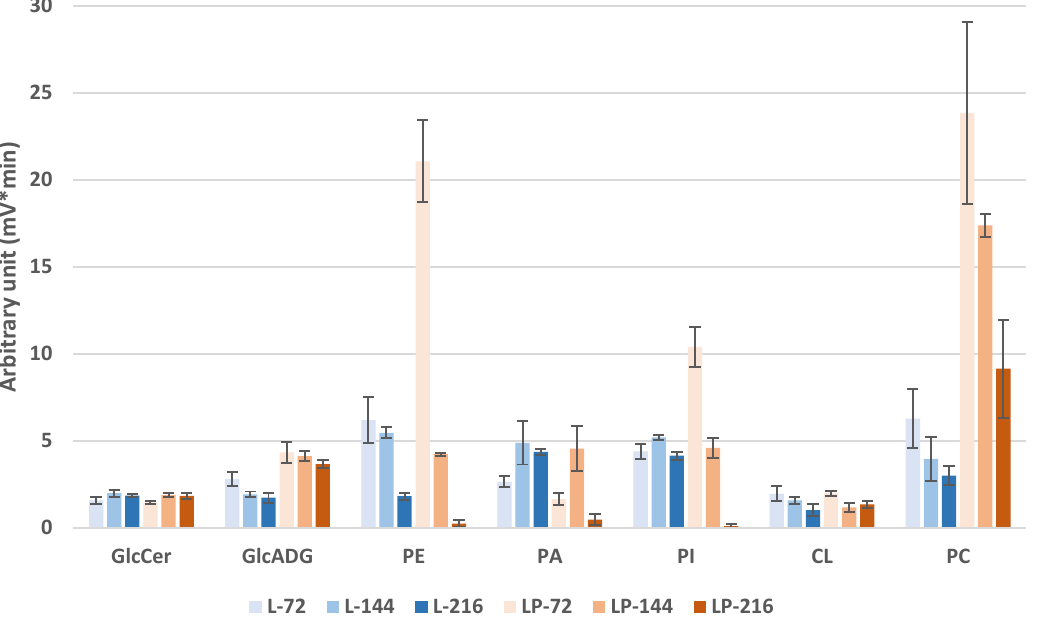
Figure 6. Comparison of membrane lipid composition in the obese L and obese LP over time. Error bars represent the standard deviation of triplicates. Mean values are displayed ( n = 3, ± SD). Lipid classes below 3% are not indicated.